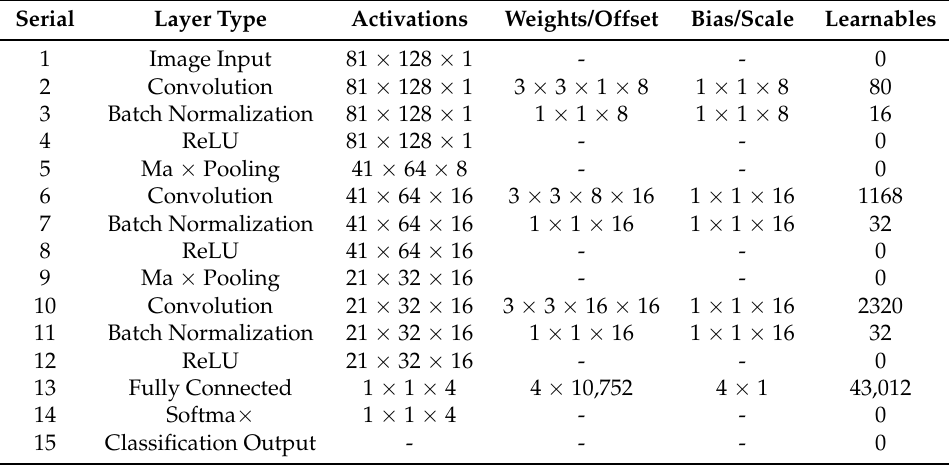
Table 1. Details of 2D-CNN